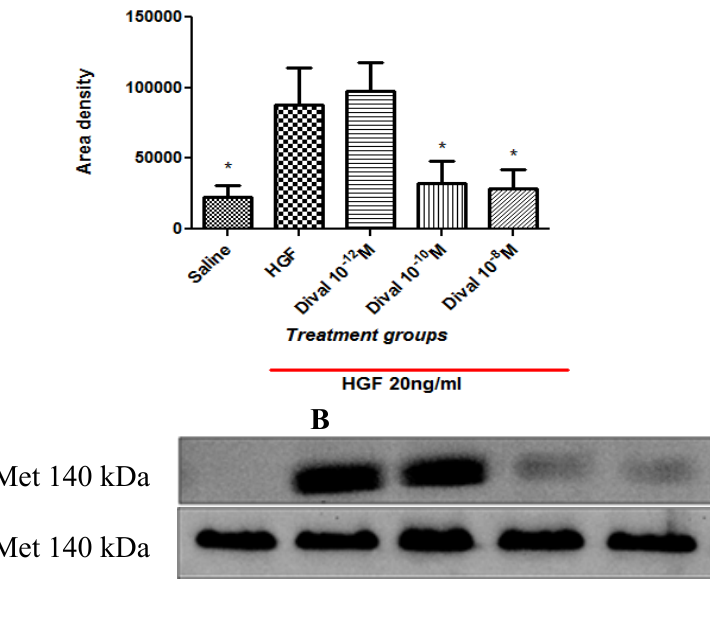
Figure 5. Divalinal inhibits hepatocyte growth factor (HGF)-dependent c-Met activation. ( A ) HEK293 cells were treated for 10 min with HGF ± divalinal at 10 − 12 , 10 − 10 , or 10 − 8 M. HEK293 cell lysates were immunoblotted with anti-phospho-Met and anti-Met antibodies. Both treatment groups (HGF 20 ng/mL + Dival at 10 − 10 and 10 − 8 M) were statistically different from the HGF treated group (* p < 0.05), but were not different from one another or non-treated controls ( p > 0.05). Mean ± SEM, N = 3. ( B ) Western blots for P-Met and